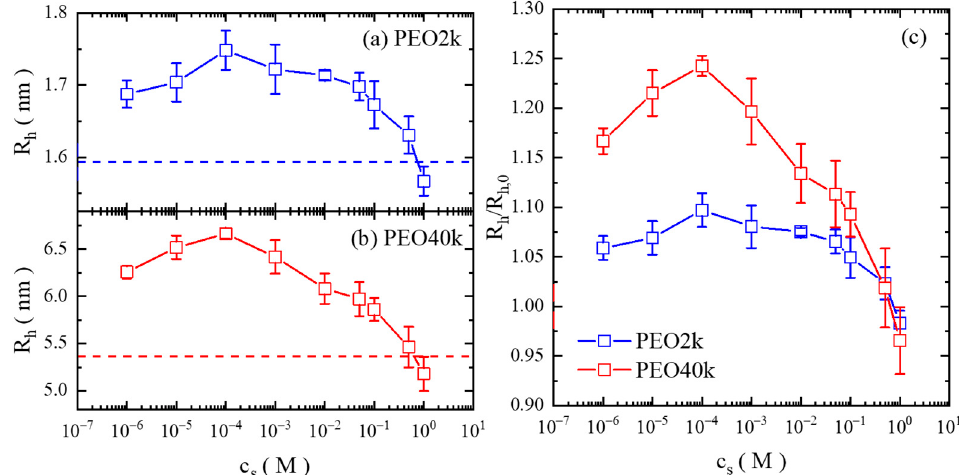
Figure 2. Values of the hydrodynamic radius ( R h ) of the PEO single chain as a function of the salt concentration in aqueous solutions: ( a ) PEO2k and ( b ) PEO40k. The dashed lines denote the value under the salt-free condition of each case. ( c ) The normalized R h value (the ratio of R h over the value under the salt-free condition, R h ,0 ).